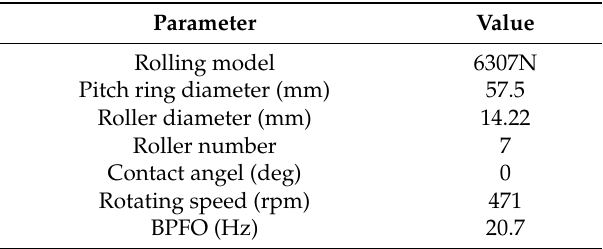
Table 2. The faulted bearing details and outer ring fault